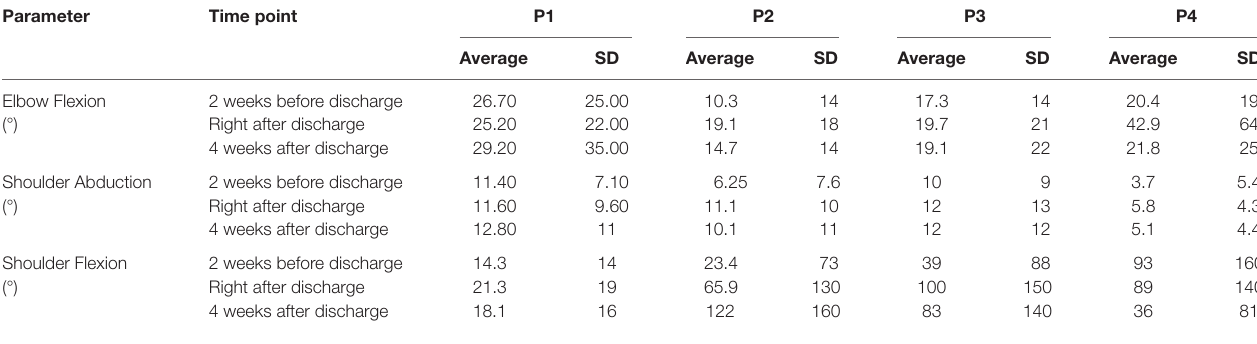
TaBle 2 | Kinematic data during a reaching movements (average joint range of motion and SD) of the effected side, for all patients (P1, P2, P3, and P4) during self- directed activities of daily living, measured over time 3 h.